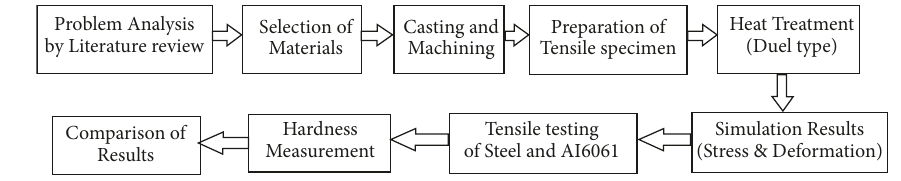
Figure 1: The layout of process methodology. Table 1: Chemical composition of EN8 carbon steel.